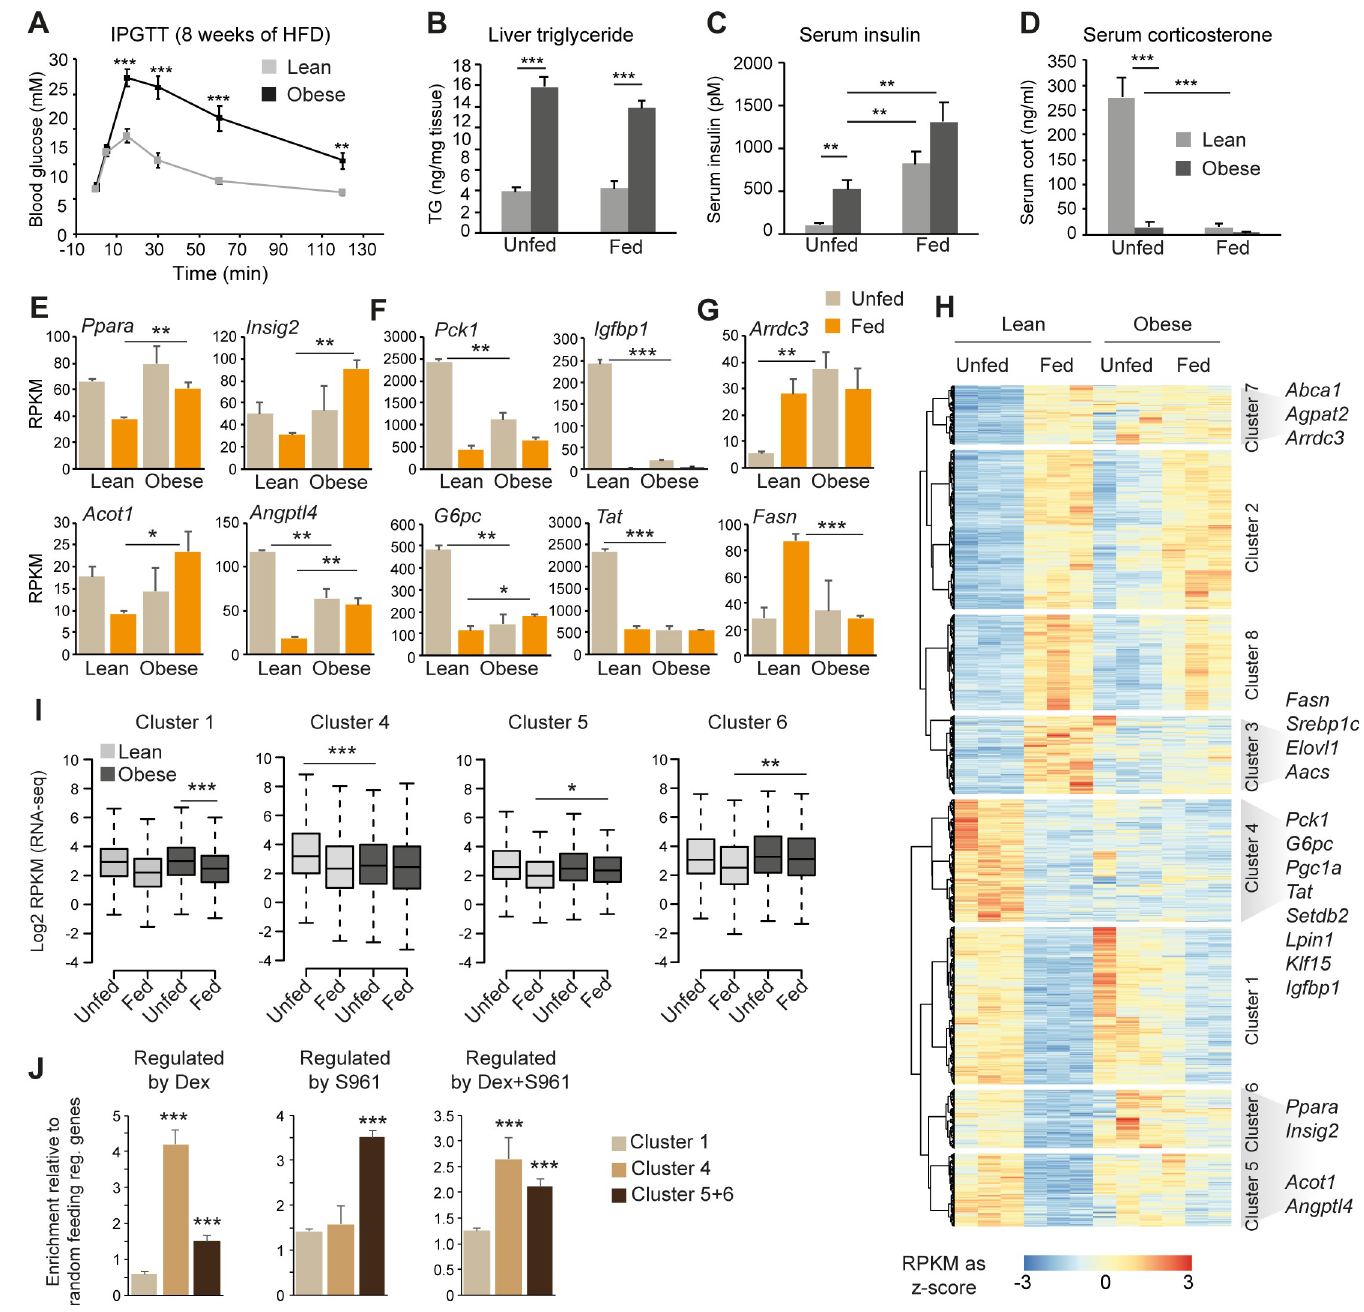
Fig 7. Postprandial gene expression in diet-induced obese mice. Mice were fed chow or HFD for 10 weeks (ad libitum). (A) Glucose tolerance test of chow-fed ( n = 8) and HFD-fed ( n = 8) animals after eight weeks on HFD. (B) Liver triglyceride levels, (C) insulin levels, and (D) corticosterone levels in chow-fed ( n = 6), chow-unfed ( n = 5), HFD-fed ( n = 5), and HFD-unfed ( n = 5) animals. (E–G) Examples of feeding-regulated gene expression in lean and obese animals. (H) Hierarchical clustering analysis of genes regulated by feeding in lean animals at FDR < 0.01 compared to feeding-regulated gene expression in obese animals. Clustering and differential expression analysis was performed using RNA-seq data from three biological replicates in each condition. RPKM values are normalized to a z-score for each individual gene across conditions. (I) Quantification of feeding-repressed genes (clusters 1, 4, 5, and 6) in livers from lean and obese mice. Statistical significance is calculated using a Mann–Whitney–Wilcoxon test on average expression between three biological replicates. (J) Enrichment of genes in clusters 1, 4, and 5 + 6 regulated by dex, S961, or dex + S961 at FDR < 0.01 relative to randomly selected feeding-regulated genes. Each condition is an average of four individual replicates. Data presented in panels A–G and J are plotted as mean ± SEM. Statistical significance is calculated using Student t test. � p < 0.05, �� p < 0.01, and ��� p < 0.001. Numerical values for panels A–H are available in S7 Data. FDR, false discovery rate; HFD, high-fat diet; RPKM, reads per kilo base per million mapped